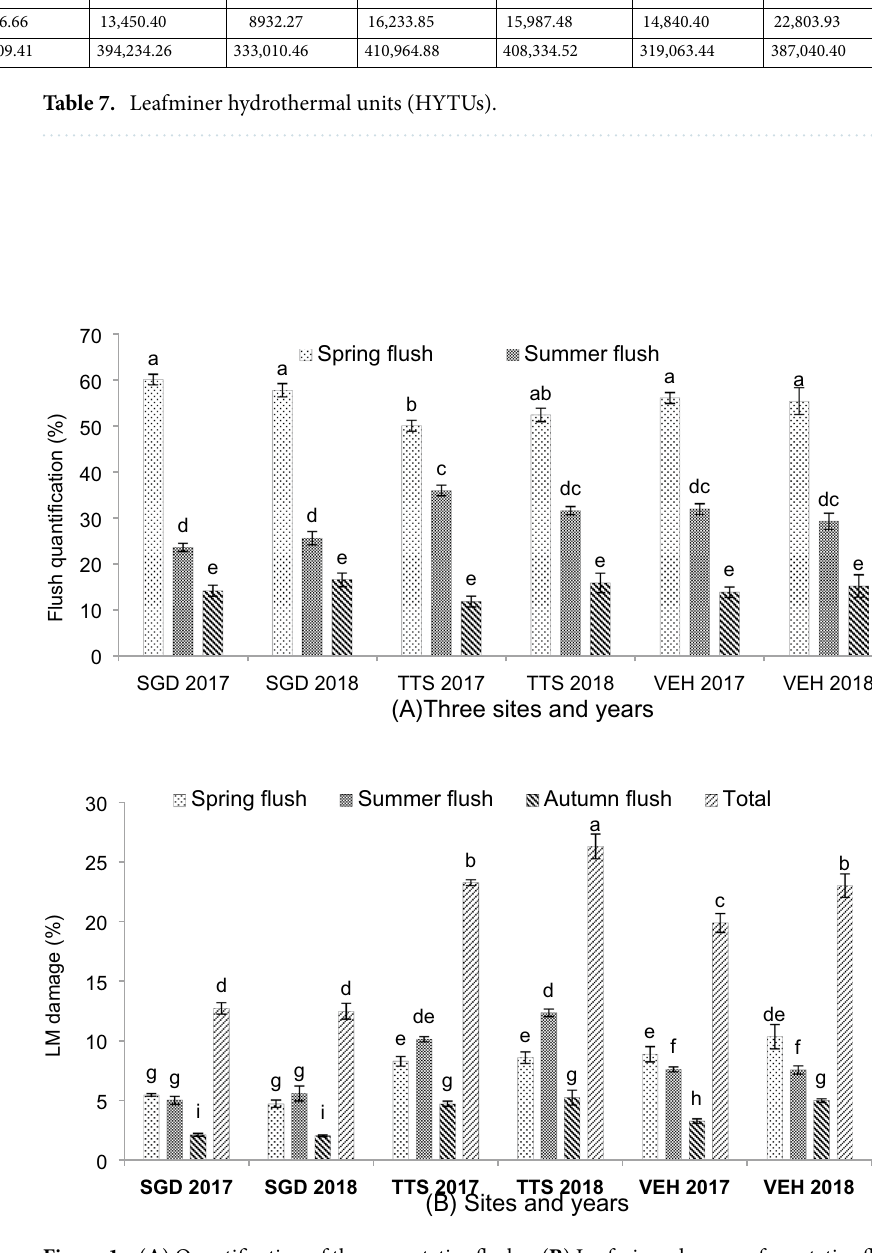
Figure 1. ( A ) Quantification of three vegetative flushes ( B ) Leafminer damage of vegetative flushes (leaves percentage). Bars sharing dissimilar letters are significantly differed according to LSD test ( P ≤